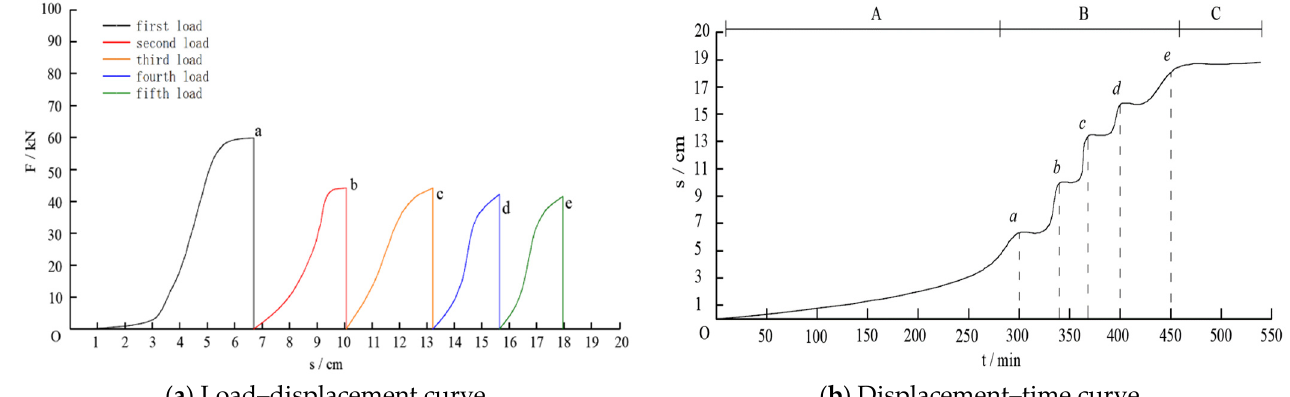
Figure 5. MTS data measured during the loading process.